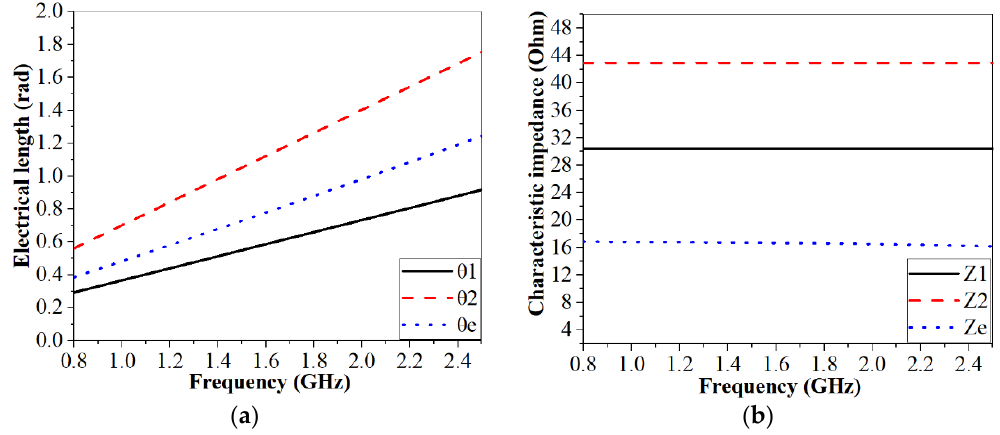
Figure 5. Electrical length ( a ) and characteristic impedance ( b ) versus frequency for TL1, TL2, and TLe.